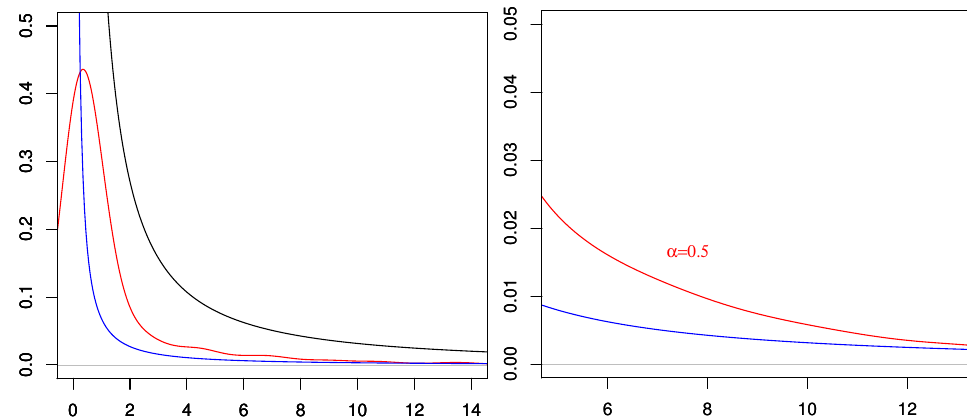
Figure 4. Case α = 0.5. Simulation details as in Figure 1. On the left , the red curve is simulated. The black curve is the plot of a ( t ) = S 1/6 · t − ( 3 + 2 α ) / ( 2 α + 2 ) with S = 0.1. Blue curve is then obtained as b ( t ) = c α · a ( t ) , with estimated value of c α = 0.1. On the right , zoom of the simulated density (red) and the approximation curve (blue), corresponding to those on the left.